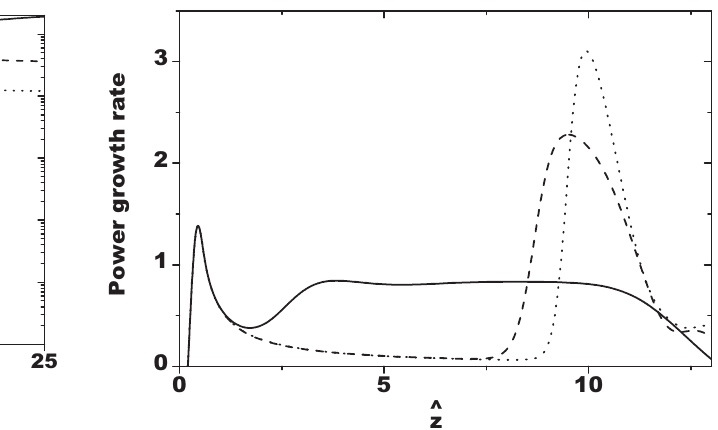
FIG. 4. Normalized power growth rate for the 1st, 3rd, and 5th (cid:3) P (cid:2) , as a function of a = (cid:1) (cid:4)P 1 beam 1 harmonic (solid, dashed, and dotted line, respectively). (cid:3) (cid:1) W (cid:2) (cid:8) (cid:1) K (cid:2) 2 = ^ (cid:5) =W =K h h h 1 1 1